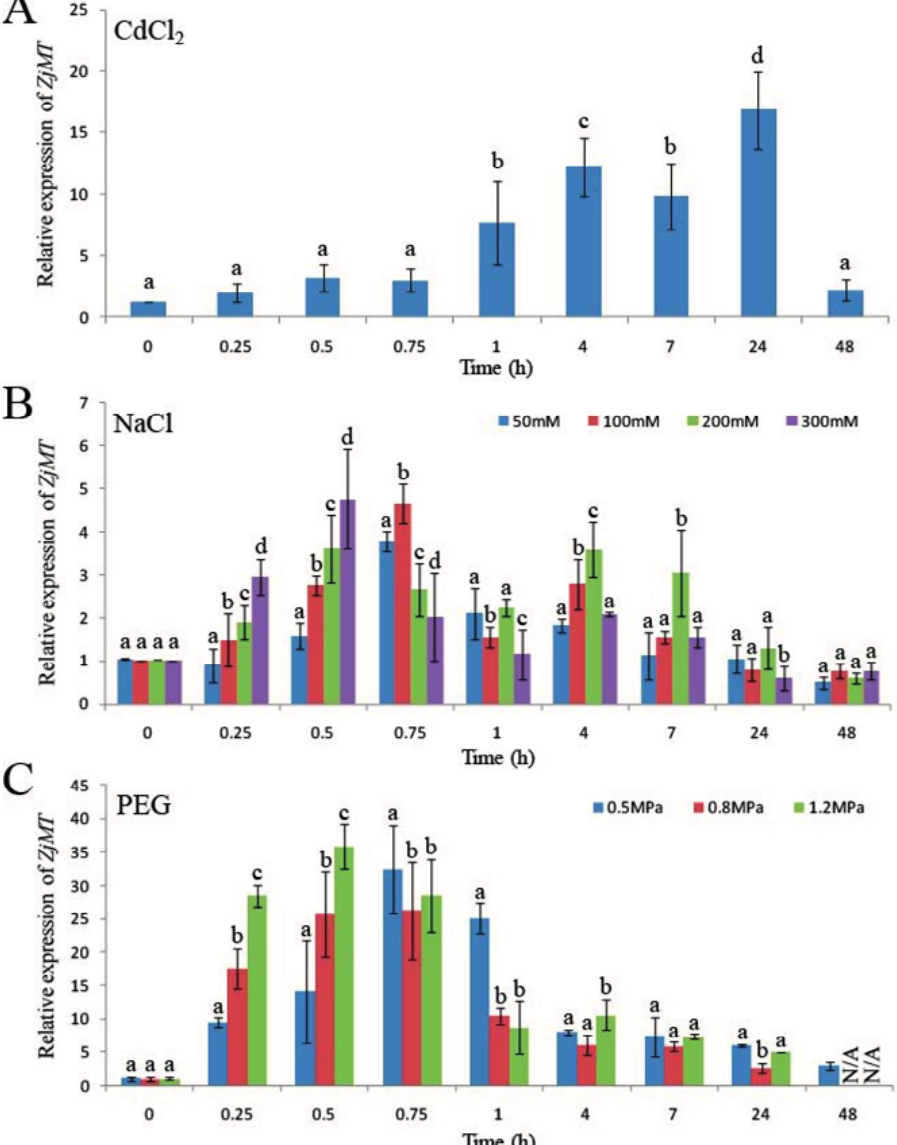
Figure 2. The expression patterns of ZjMT . The relative expression levels of ZjMT gene in leaves under CdCl 2 ( A ), NaCl ( B ) and PEG ( C ) stress were measured using qRT-PCR. Six-week-old Z. jujuba young seedlings were treated with 100 mM CdCl 2 , 50, 100, 200 and 300 mM NaCl, and 10% PEG 6000 under different conditions at indicated time points. Different letters (a–d) indicate statistically significant differences between means at p < 0.05 (Student’s t -test). N/A: Not applicable. Standard errors were calculated from three biological replicates in which ZjH3 (an actin gene, accession number EU916201) transcripts were used as internal controls. The 2 −ΔΔ C t method was used to measure the relative expression levels of the target gene in stressed and non-stressed leaves. Error bars represent standard